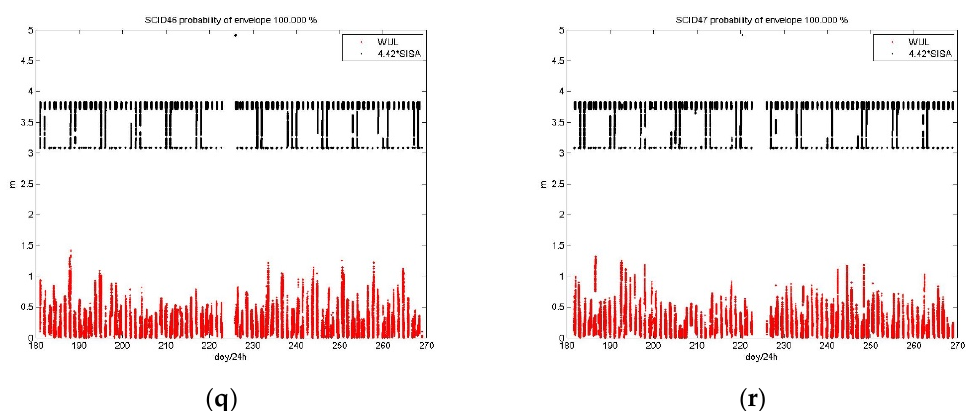
Figure 6. URE and 4.42 × SISA sequences of BDS-3 satellites from 1 July 2019 to 25 September 2019. ( a ) PRN 19; ( b ) PRN 20; ( c ) PRN 21; ( d ) PRN 22; ( e ) PRN 23; ( f ) PRN 24; ( g ) PRN 25; ( h ) PRN 26; ( i ) PRN 27; ( j ) PRN 28; ( k ) PRN 29; ( l ) PRN 30; ( m ) PRN 32; ( n ) PRN 33; ( o ) PRN 34; ( p ) PRN 35; ( q ) PRN 36; ( r ) PRN 37.